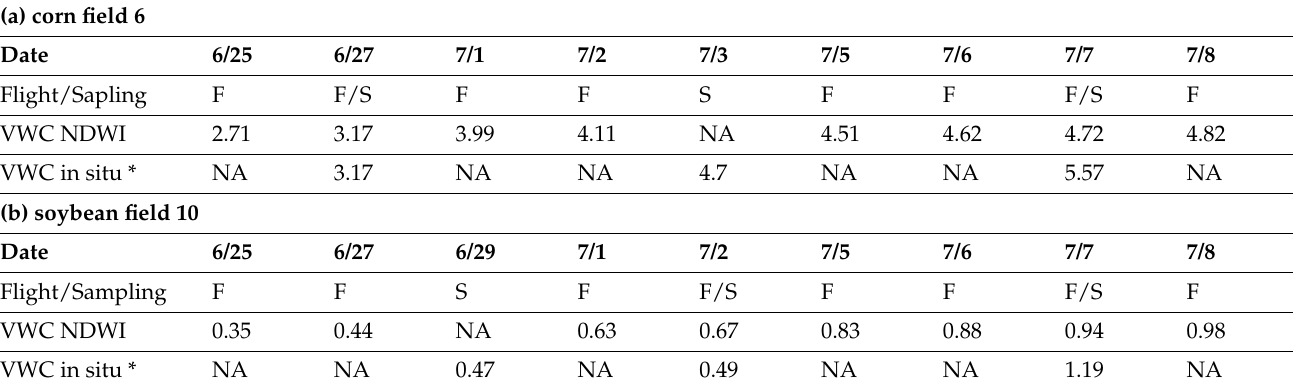
Table 2. Comparison of VWC derived from NDWI and VWC sampled from in situ during flight period. The label flight (F) stands for days the radar measurements were taken. The label sampling (S) stands for days when VWC samplings were taken in fields.